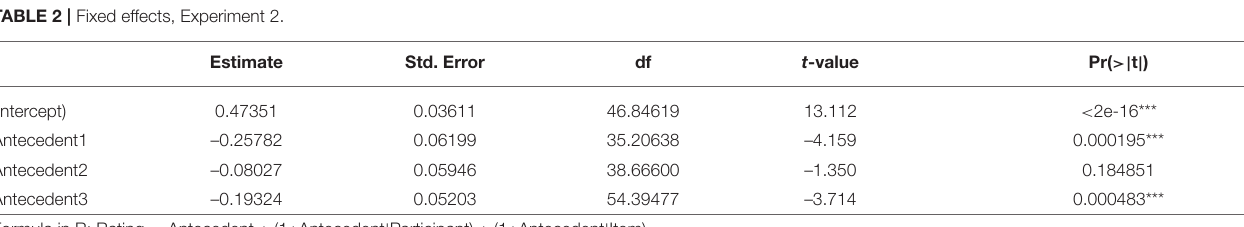
TABLE 2 | Fixed effects, Experiment